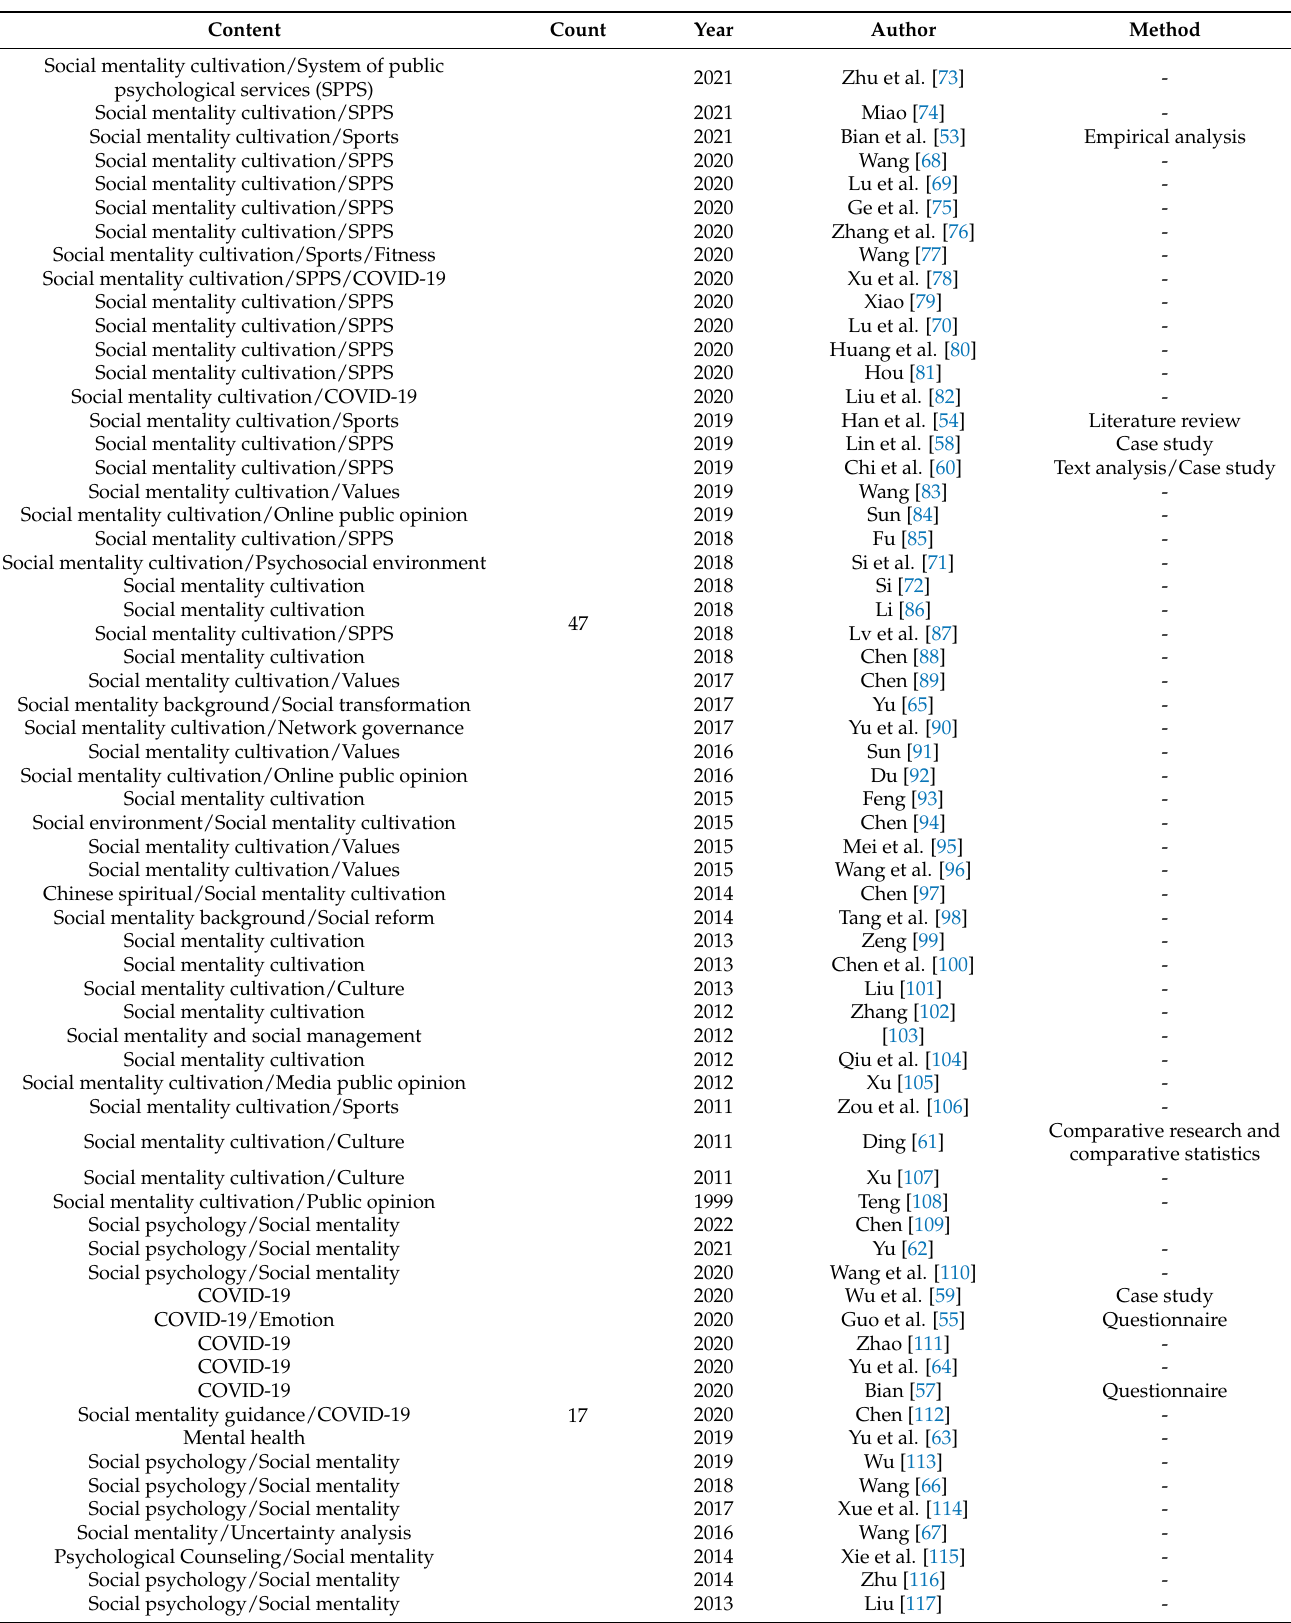
Table 3. Statistics of clusters on social psychology and healthy social mentality in the CNKI before 1 April 2022 (generated by the